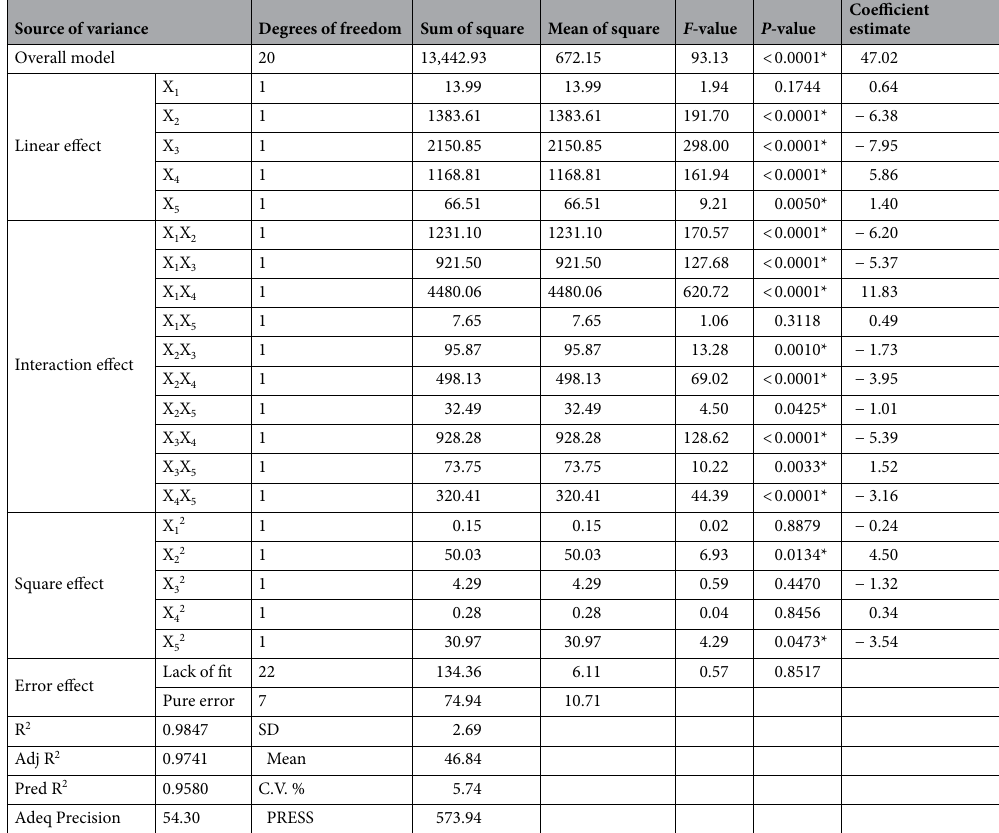
Table 2. Analysis of variance for simultaneous biosorption of Congo red by E. intestinalis achieved by the FCCCD. *Significant values, F , Fishers’s function; P , level of significance; C.V, coefficient of